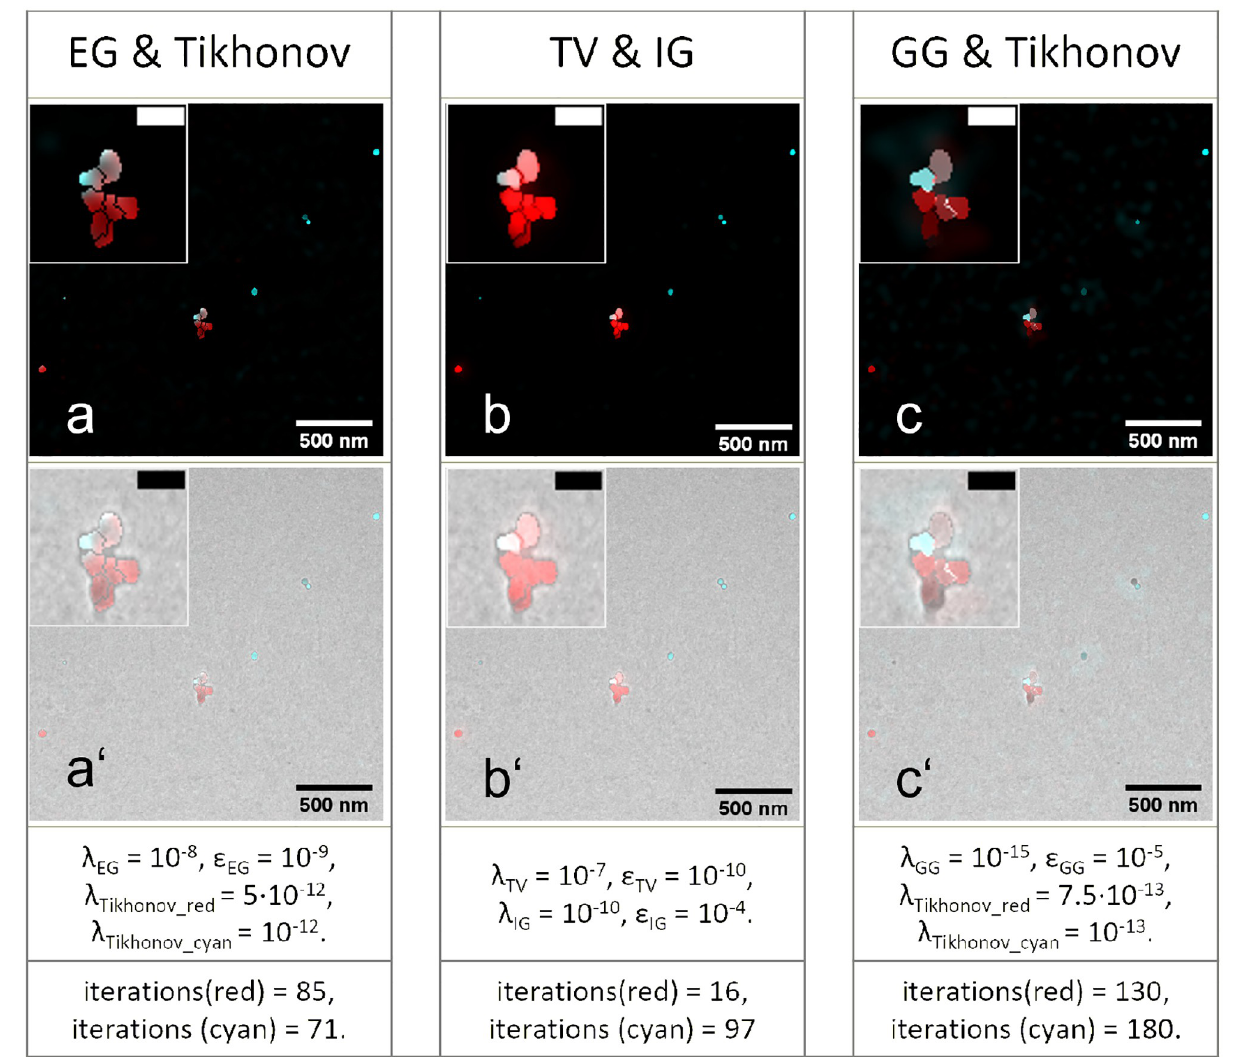
Fig 4. EM-guided deconvolution of the bead sample. The restored LM images from the same region as shown in Fig 3 using a) EG & Tikhonov, b) combined TV with IG and c) GG & Tikhonov deconvolution. Respective overlays with the aligned EM images are presented in the panels below. The window on the top-left corner of each image shows the details of the cluster (scale bar is 100 nm). The orange beads were color coded in cyan and we stretched the lookup table to 40% of the maximum value for a better visualization of dim structures.